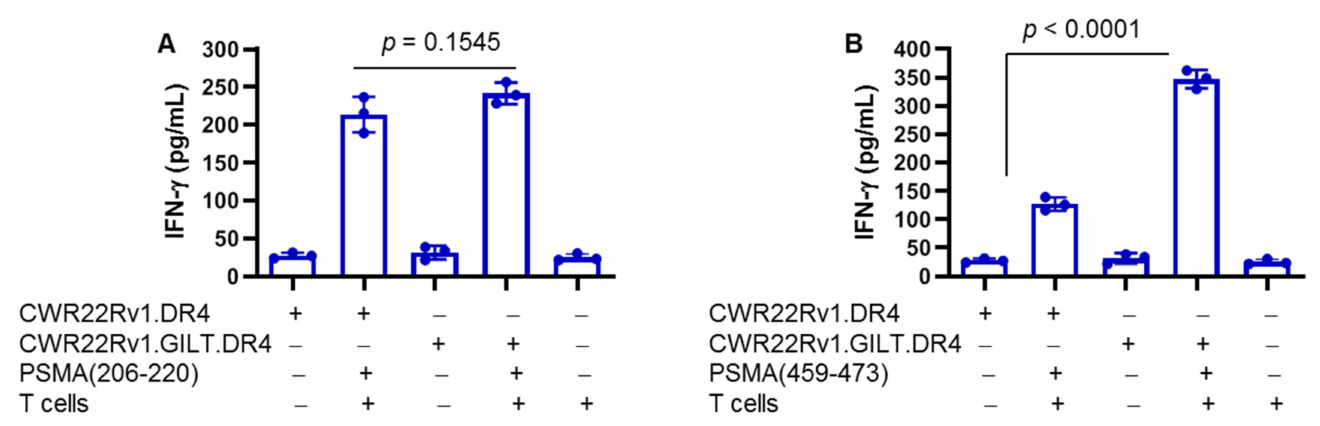
Figure 5. CD4 + T cell recognition of PSMA peptides on prostate cancer cells. CWR22Rv1 and CWR22Rv1.GILT cells were retrovirally transduced with HLA-DR4 as described in the meth- ods. CWR22Rv1.DR4 and CWR22Rv1.GILT.DR4 cells were then incubated with the PSMA (206–220) ( A ) and PSMA (459–473) ( B ) peptides (20 µ m) overnight at 37 ◦ C and were washed and fixed with